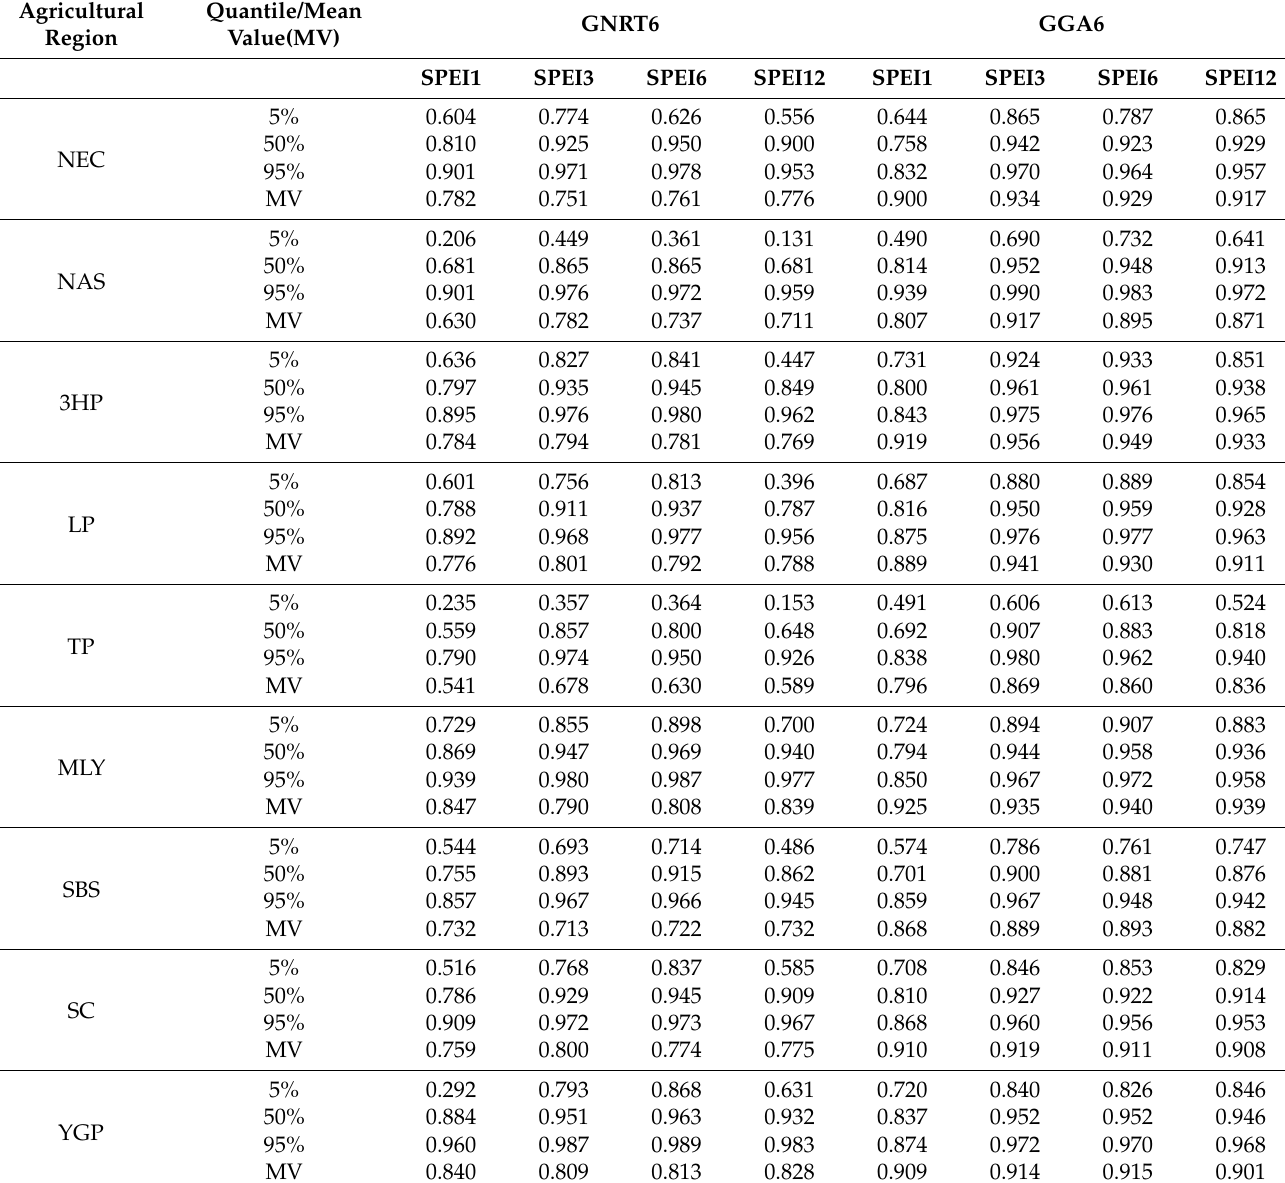
Table 5. CC of the 1-, 3-, 6- and 12-month SPEI calculated by GNRT6 and GGA6 for the nine agricultural regions. The gray-filled data represents the maximum average CC of the four SREs in the region and time